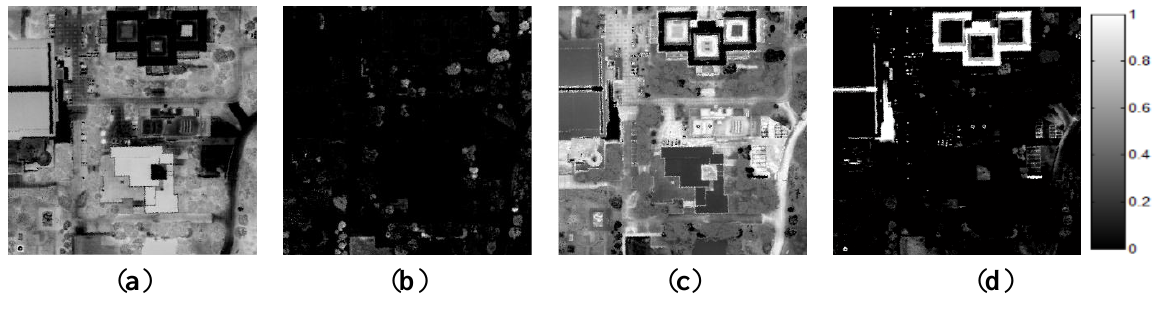
Figure 13. Abundance maps of the final endmembers in the CASI data obtained using